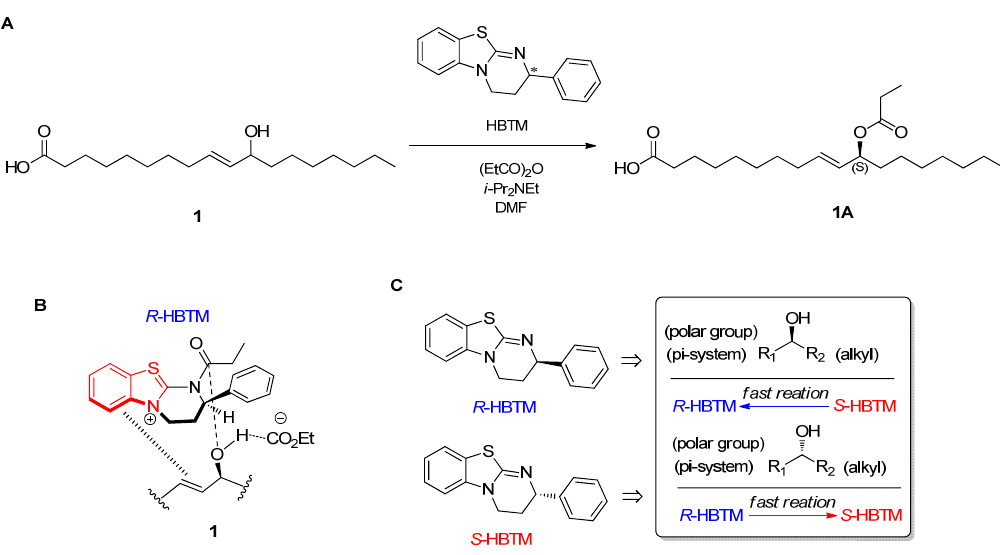
Figure 3. ( A ) CEA reaction for determining the absolute configuration of compound 1 . ( B ) Proposed favorable transition state of compound 1 in the reaction. ( C ) Mnemonic to predict the configuration of secondary alcohols in the CEA reaction.